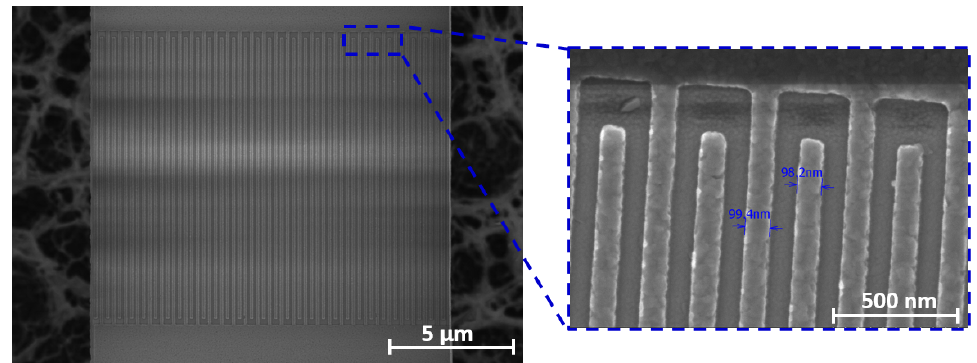
Figure 6. SEM micrograph of released 60-finger AlScN CLMR with the zoomed in view of ∼ 100 nm wide finger electrodes shown in the